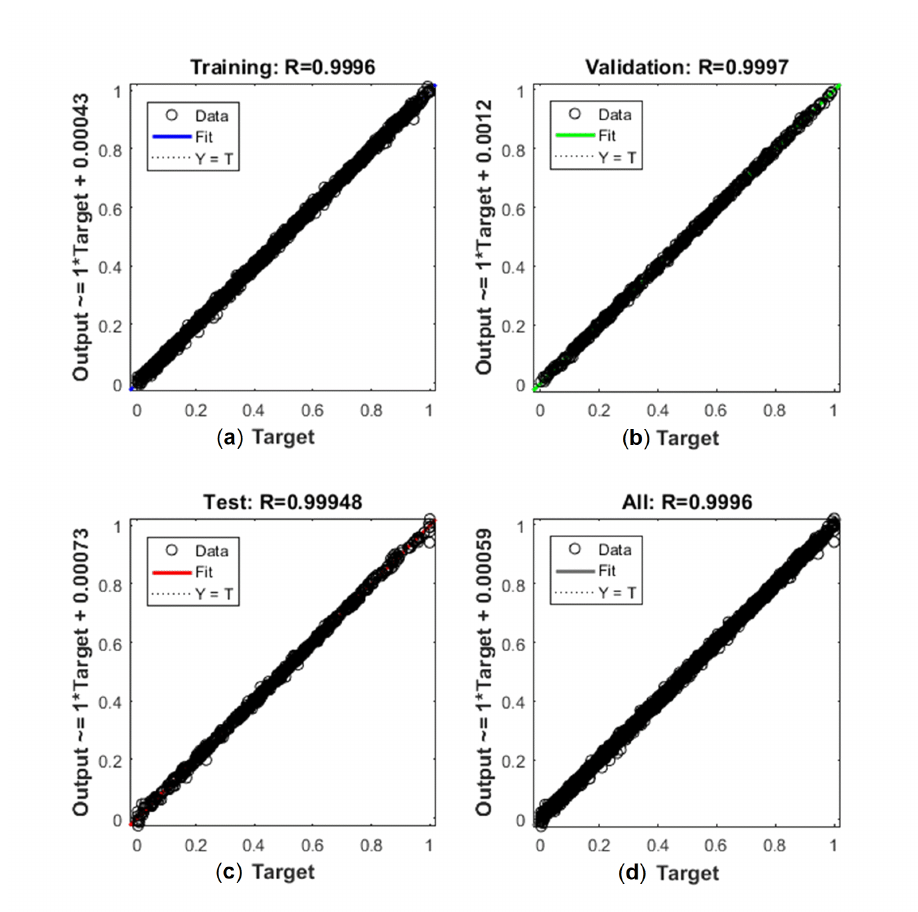
Figure 7. Regression Analysis of the Neural network’s output using ( a ) training sample set